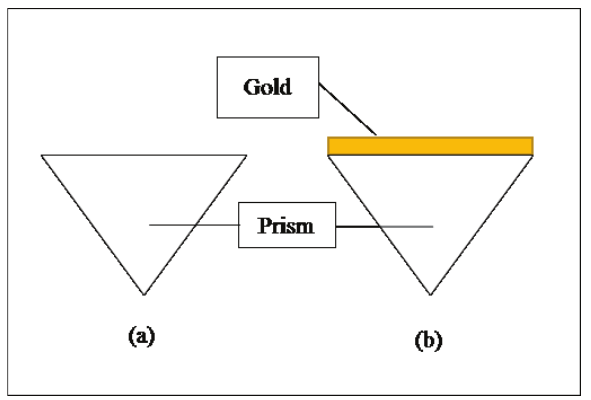
Fig. 5(a). Bare prism (b) gold-coated prism in Kretschmann configuration.